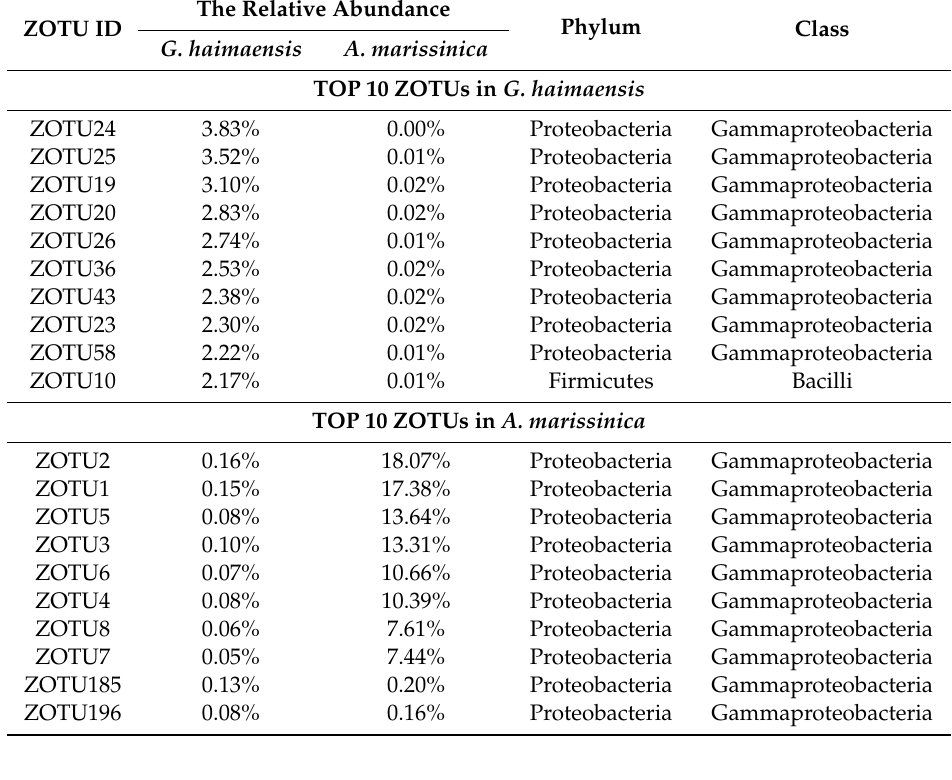
Table 1. Phylogenetic classification and their relative abundance of the top 10 ZOTUs (zero-radius operational taxonomic units) in bathymodiolin mussel Gigantidas haimaensis and vesicomyid clam Archivesica marissinica .